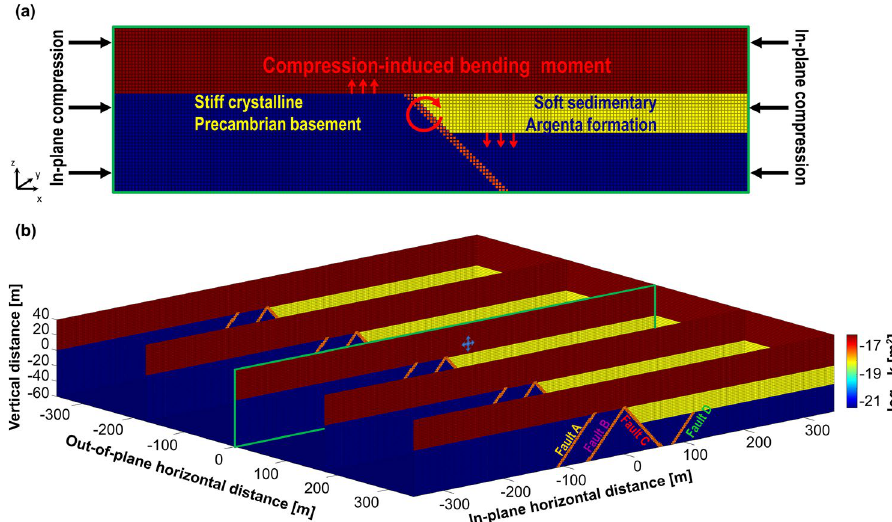
Figure 5. ( a ) Sketch of the mechanism of the bending moment on the interface between Argenta and Precambrian rhyolite induced by in-plane horizontal compression. ( b ) Problem layout for the numerical model with the same geometry in the out-of-plane horizontal direction that contains 5 grid points. In-plane geometry includes Mt. Simon, Argenta, Precambrian rhyolite, three high-permeable faults in the basement without an offset, and the high permeable fault with an offset. In-plane resolution is 81 grid points in the vertical direction and 567 grid points in the in-plane horizontal direction. The injection point is shown with a star, and overpressure of 2 MPa at the injection point is kept constant. Three high permeable faults (Fault A, B, C) with direct connection to the reservoir and one high permeable fault (Fault D) isolated by Argenta formation are